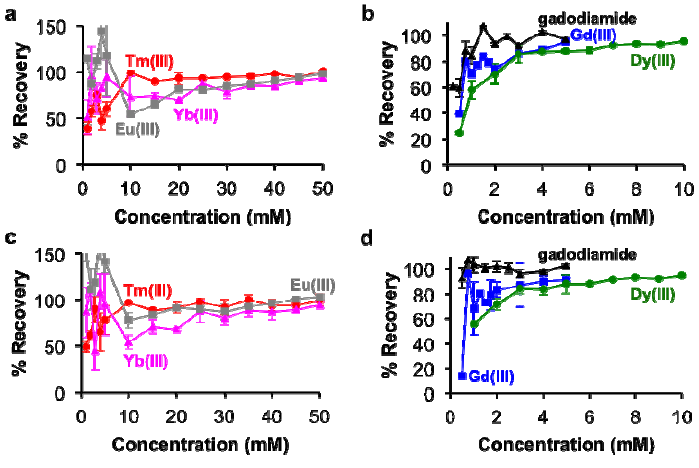
Figure 6. The recovery of lanthanide ions from ( a , b ) rat kidney tissues and ( c , d ) rat liver tissues. (a,c) At least 80% recovery was obtained for samples with ≥ 25 mM Tm(III), Yb(III), and Eu(III). (b,d) At in 85% recovery was obtained for samples with ≥ 3 mM Gd(III), gadodiamide, and